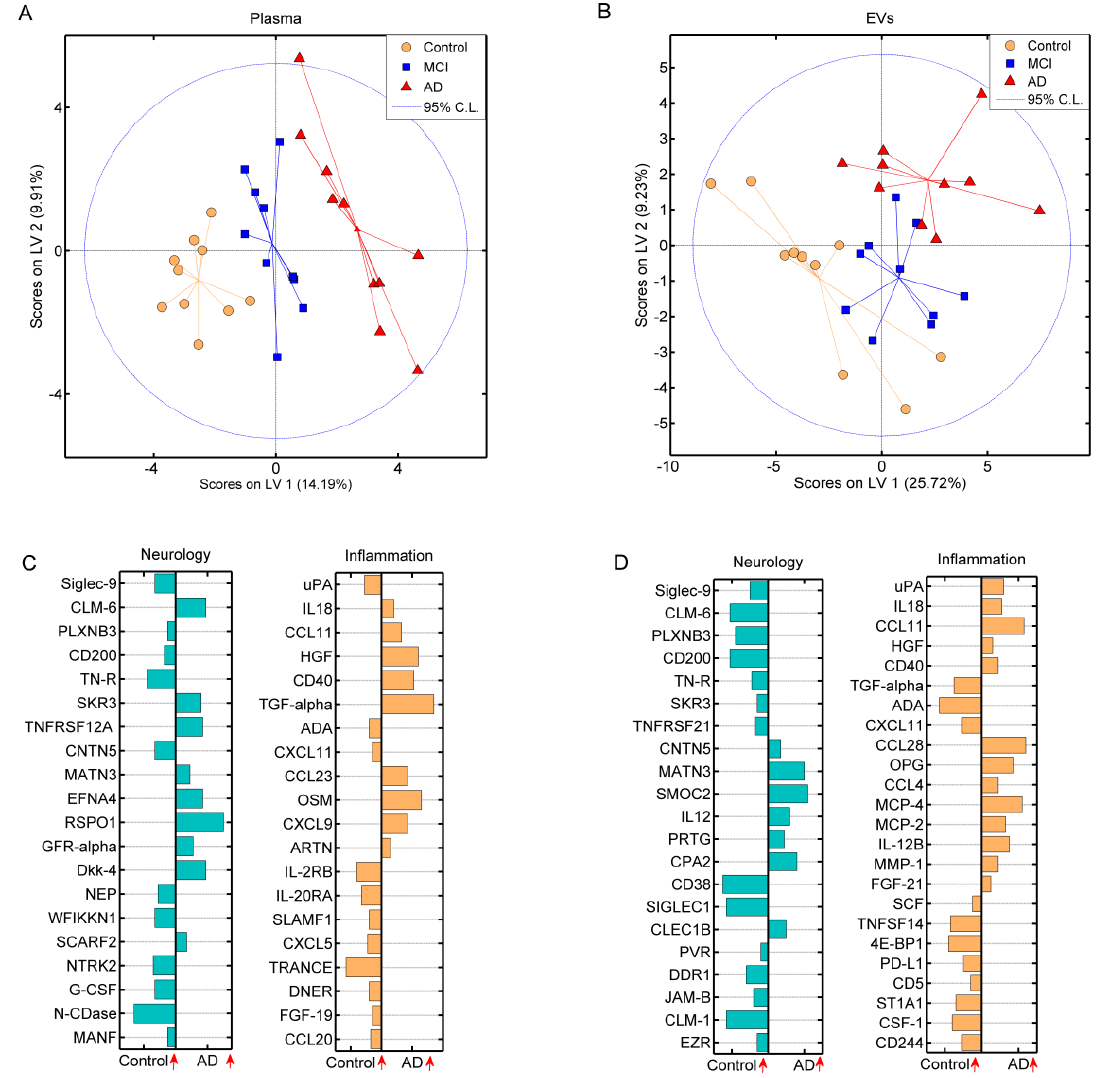
Figure 3. Partial least squared discriminant analysis of proteins from the Neurology and Inflammation panels measured in plasma and EV samples. Scores plots for all three groups measured in ( A ) plasma and ( B ) EV samples, where each score represents a sample. Loadings plots of ( C ) plasma and ( D ) EV samples, where each loading represents the variation in a specific protein. The larger the bar, the more significant the protein is in sample grouping. The orientation of each loadings’ variable describes if the corresponding protein was found at higher levels in controls compared to AD patients, where the vertical arrows were provided to facilitate